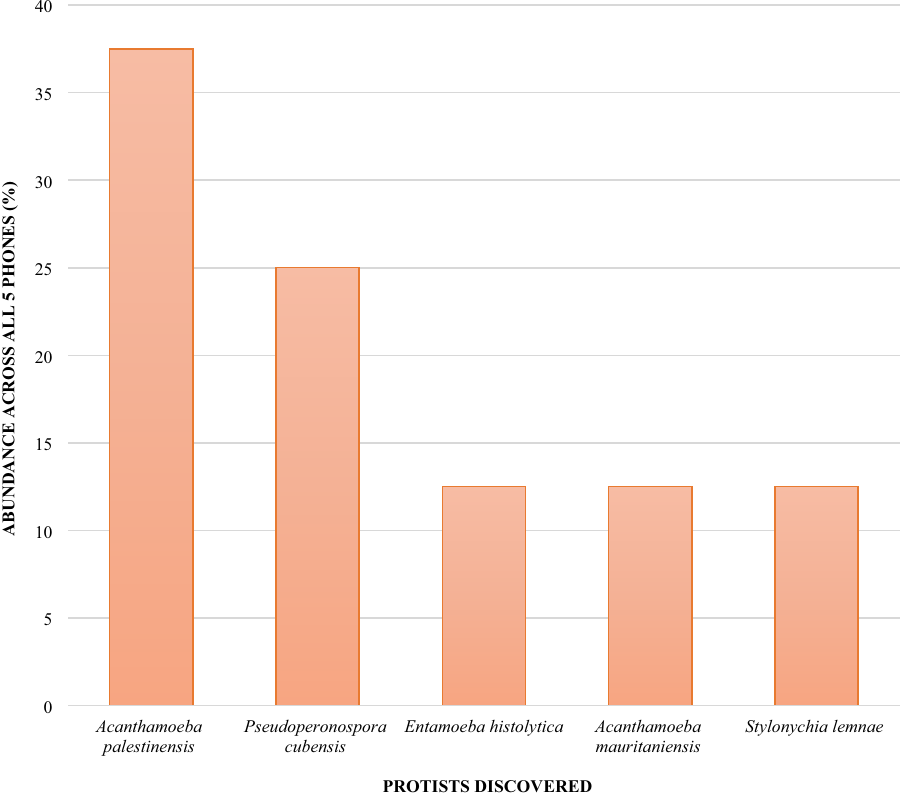
Figure 4. Relative abundance of protists identified on community derived